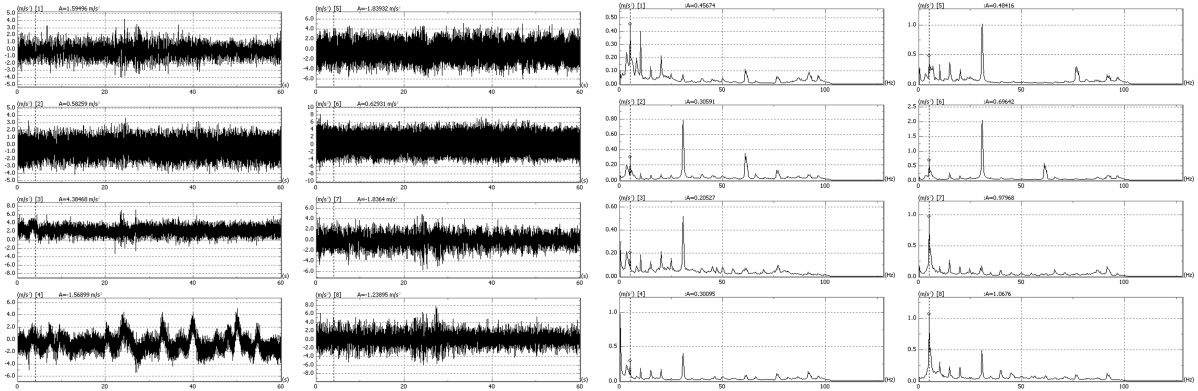
Fig. 9 Waveform and spectrum of each measuring point at a speed of 60 Km/h.